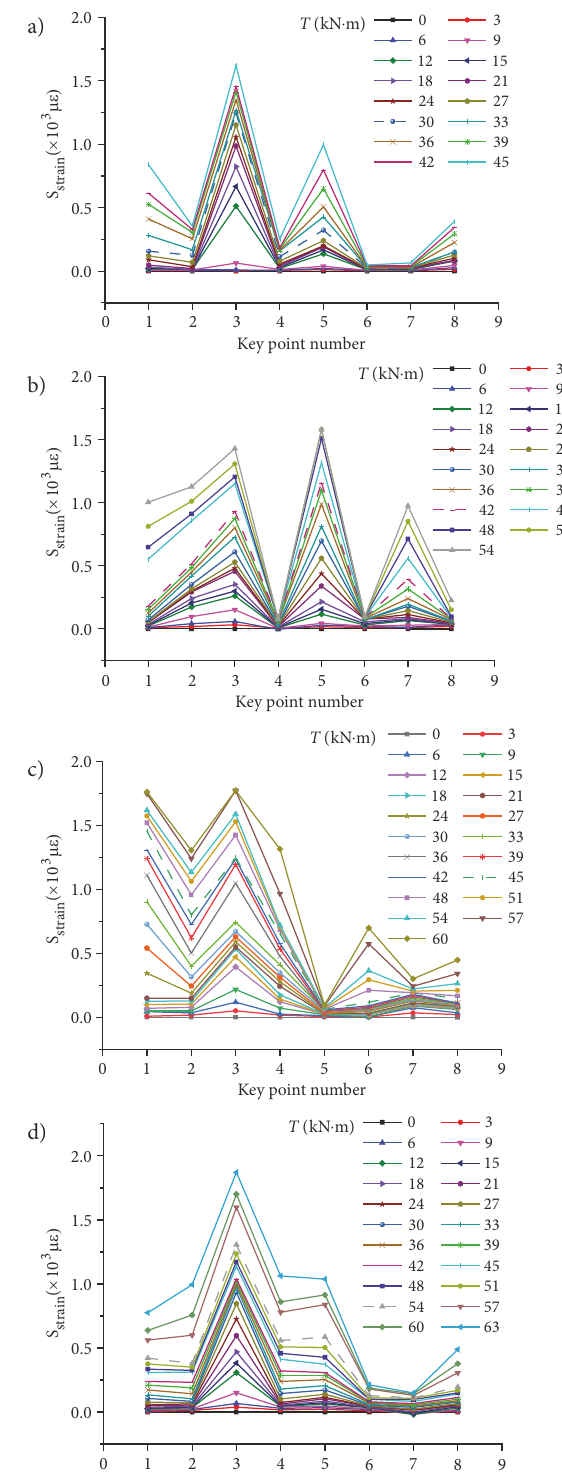
Figure 8. GSED-based analytical approach for RC box-girders with different wrapping schemes